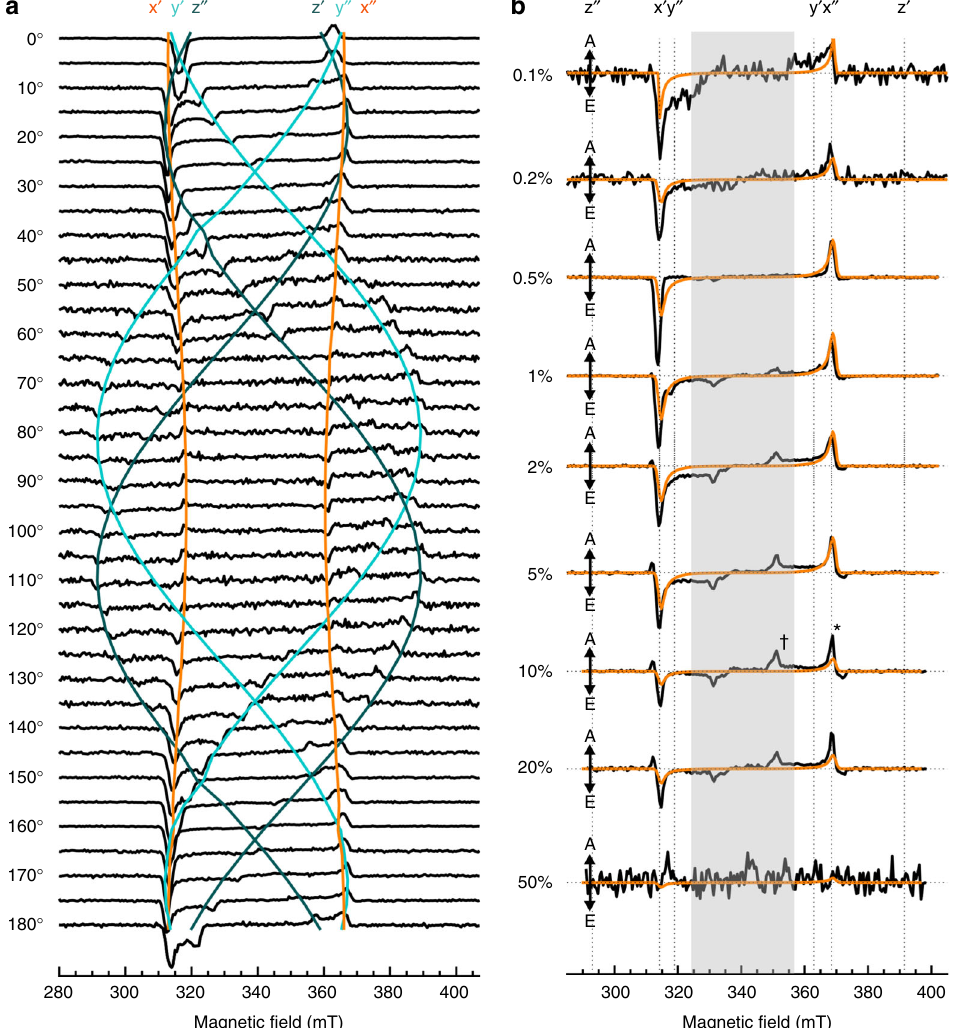
Fig. 4 tr-EPR of ordered pentacene fi lms as a function of orientation and concentration. a tr-EPR spectra of the 1 µ m 0.5% pentacene doped p -terphenyl fi lm at different orientations within the magnetic fi eld taken at time 400 ns. Angles are de fi ned as between the normal to the substrate and the magnetic fi eld direction. The coloured traces are simulations of the rotation pattern of each molecular axes, calculated for the two inequivalent sites in the crystal lattice, where orange, cyan and teal correspond to x, y and z, respectively. b tr-EPR spectra acquired in the x -orientation as a function of pentacene concentration with the simulated triplet contribution shown in orange. The spectral slices are taken at the maximum signal, time 400ns below 10% and at 500 ns above 10%. The inner peaks found in the shaded area, which do not belong to isolated triplets, are assigned to long-lived strongly coupled triplet states. The (*) and ( † ) on the 10% spectra represent the triplet and quintet absorption peaks,